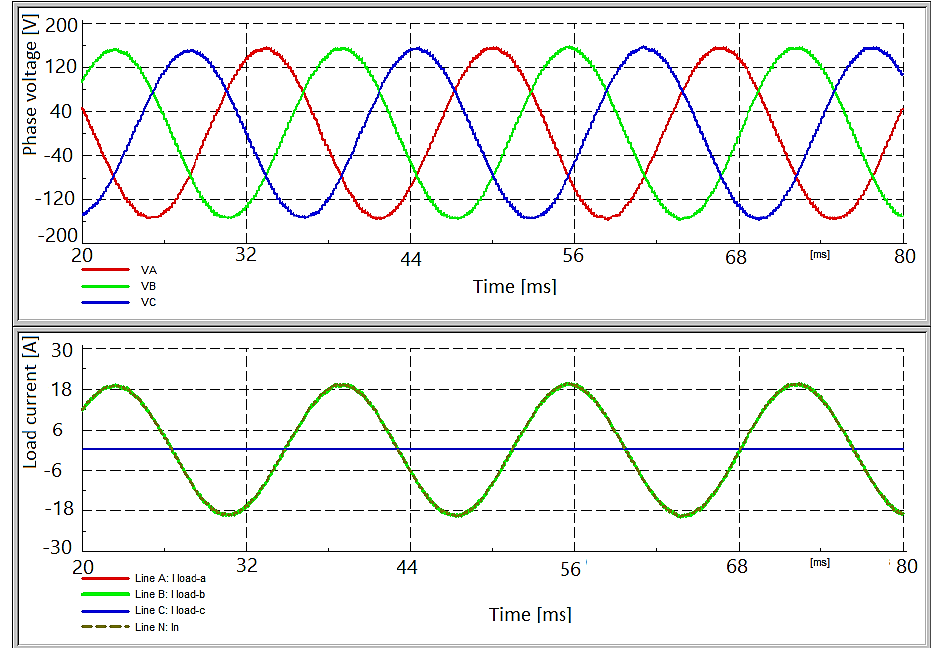
Figure 17. Output three-phase voltages and currents for Unb.#3. Table 3. Comparison between two control strategies in the steady-state.